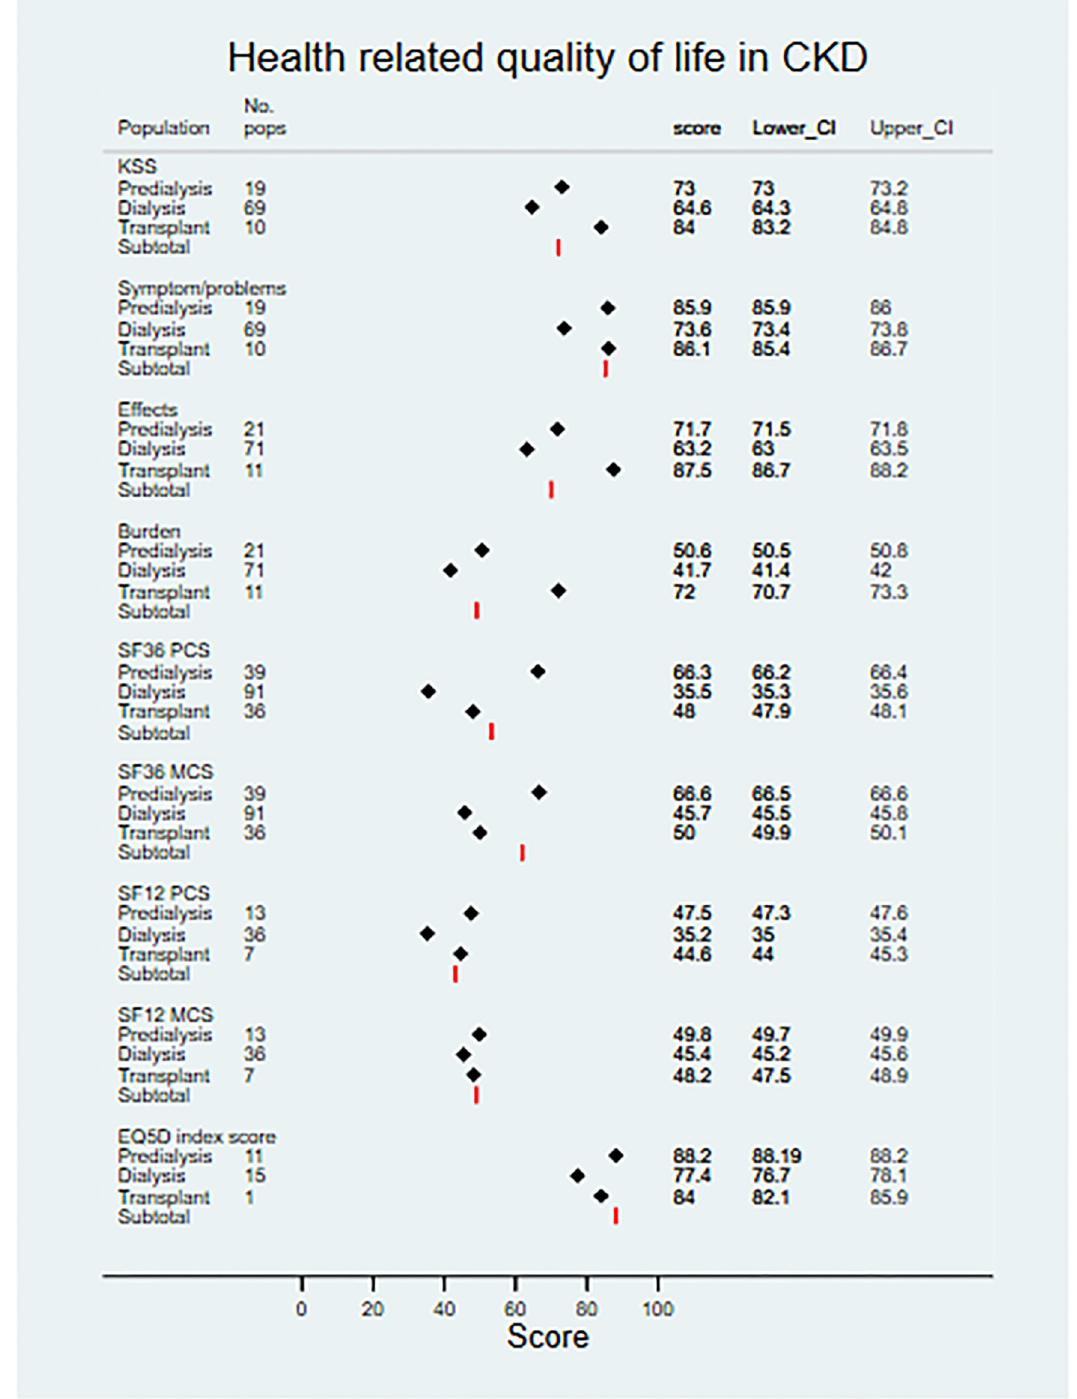
Fig 10. Health-related quality of life in CKD. CKD, chronic kidney disease; EQ5D, EuroQoL–5 Dimension; KSS, Kidney Disease Quality of Life Summary Score; MCS, Mental Component Summary; No. pops, number of populations; PCS, Physical Component Summary; SF12, 12-Item Short Form Health Survey; SF36, 36-Item Short Form Health Survey.